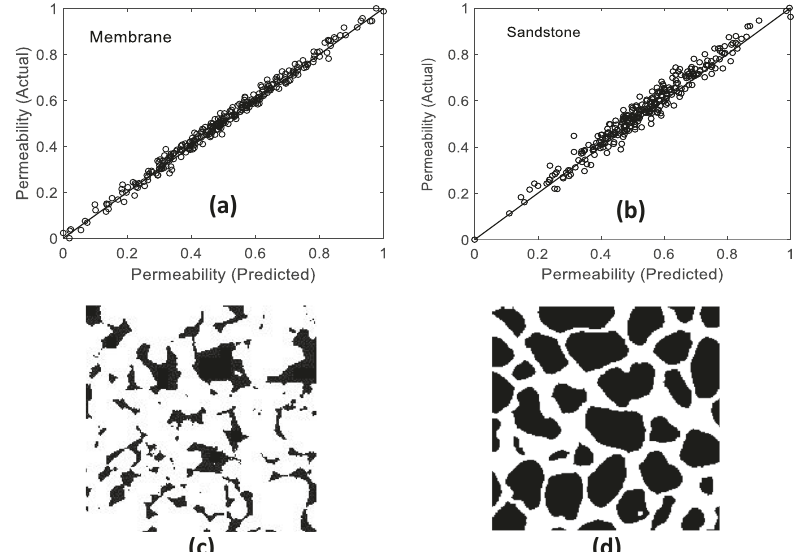
Fig. 7 PIRED ef fi ciency in predicting permeability of another porous medium, a sandstone. Comparison of the actual and predicted permeabilities K ( K is normalized according to ð K (cid:1) K min Þ = ð K max (cid:1) K min Þ ) for ( a ) 300 2D images of the membrane, whose morphology is shown in ( c) , and ( b ) for 100 images of a sandstone, the morphology of which is shown in ( d ). In ( c ) and ( d ), black and white represent the solid matrix and the pores, respectively.